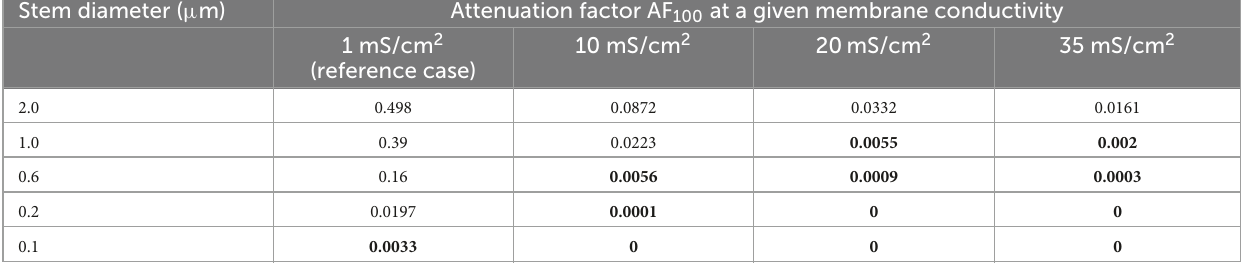
Subcritical AF 100